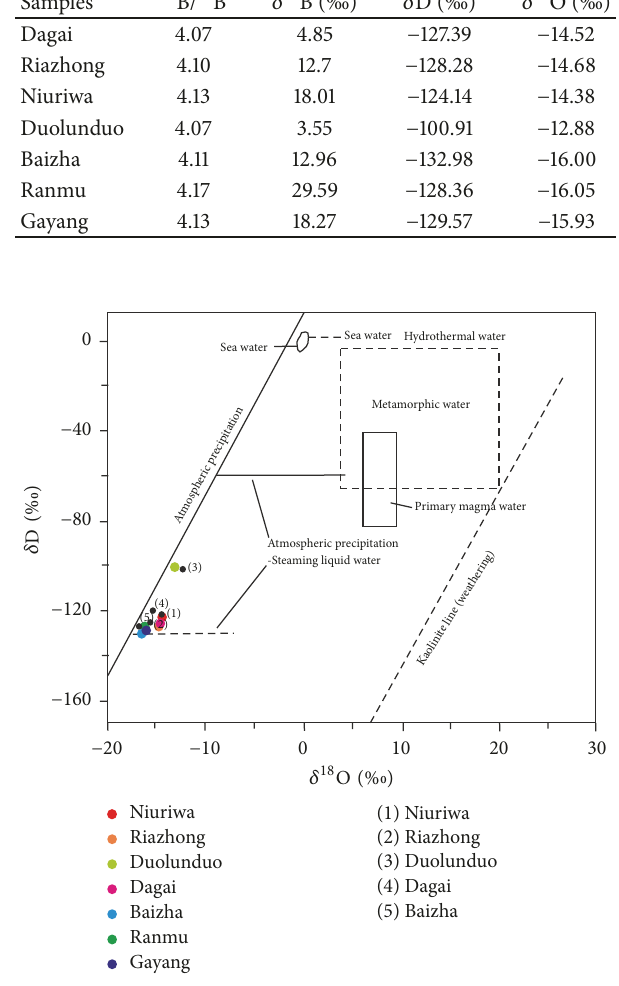
Figure 2: The H-O isotopic composition of the saline springs.